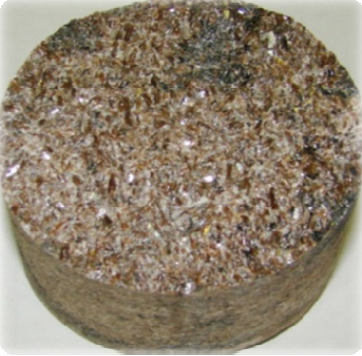
Figure 2. Titanite crystals in a rock sample (crystal color—light brown).